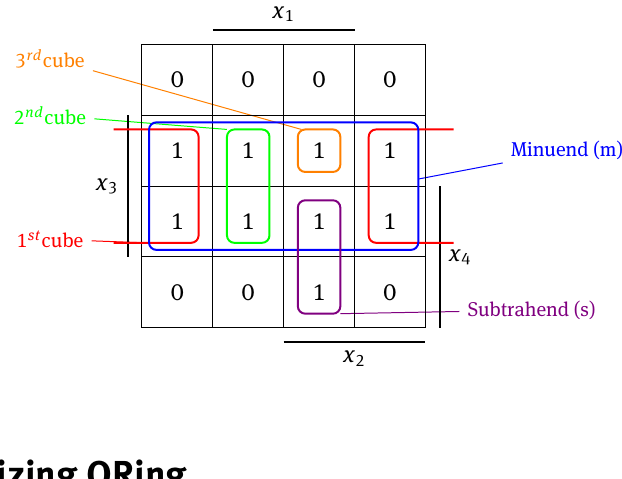
Fig. 1. Example 4.2 in a